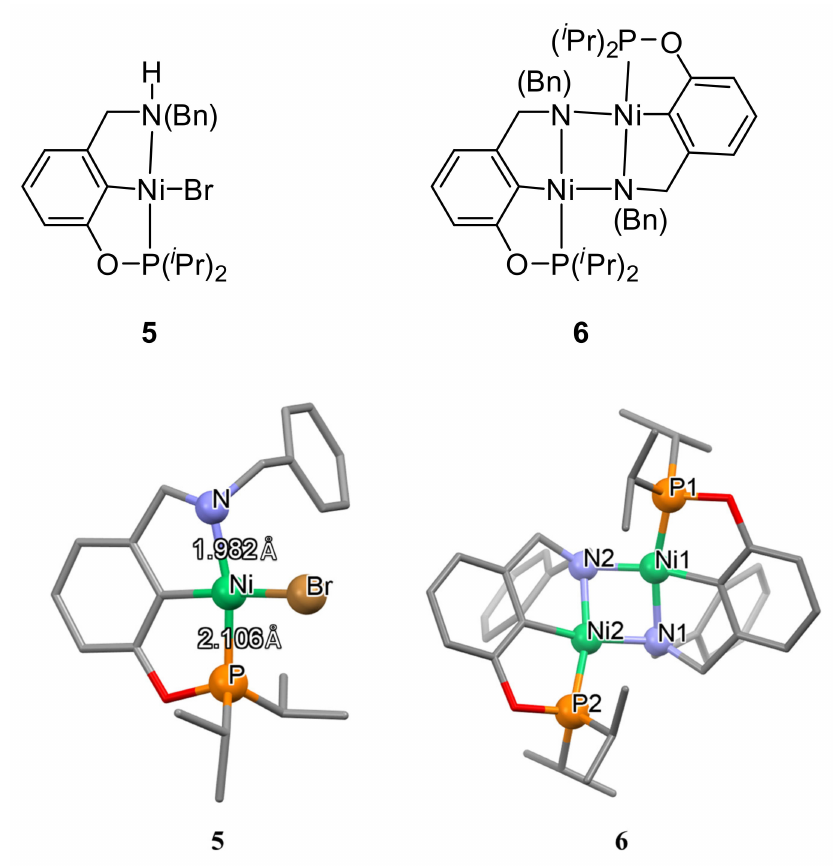
Figure 3. Structure of unsymmetrical POCN pincer nickel complexes 5 and 6 [79]